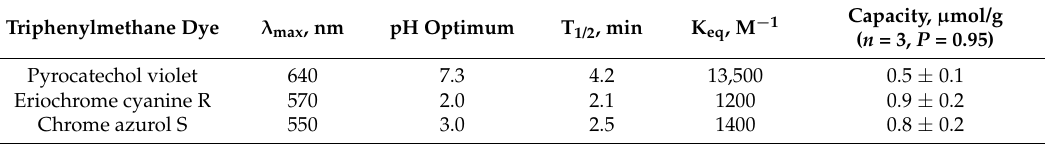
Table 1. Characteristics of the interaction of silica–titania xerogels with triphenylmethane dyes. Triphenylmethane Dye